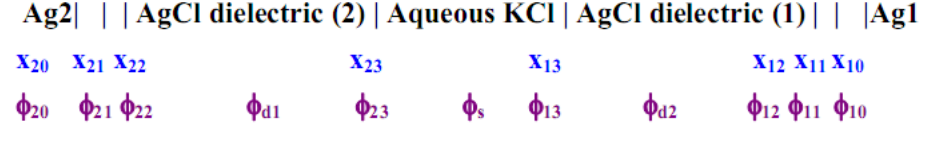
Figure 7. Sketch of interfacial region with associated